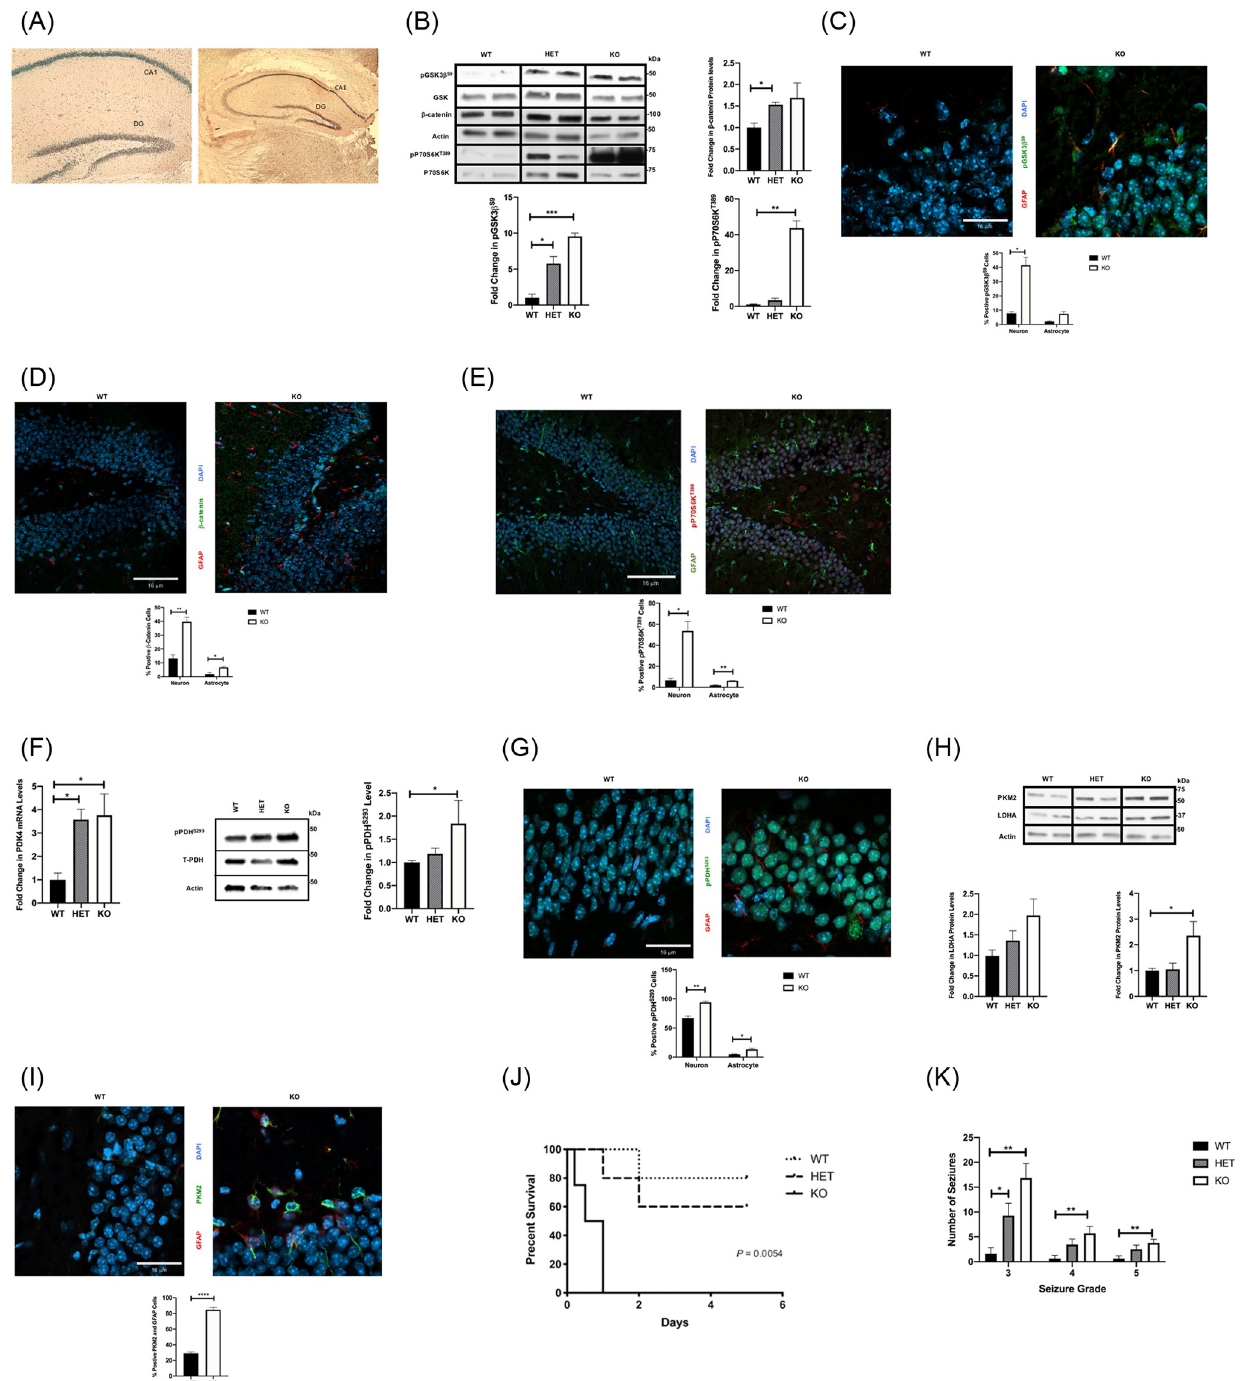
Fig 7. The role of HBP1 and Wnt signaling in acquired seizure susceptibility. (A) HBP1 gene is expressed in the CA1 and DG regions. The expression pattern of the HBP1 gene was determined in the HBP1 -/- mouse through the inserted β -galactosidase gene. Note that the HBP1 -/- mouse was generated by insertion of the β -galactosidase gene into intron 1 of the HBP1 genomic loci [72]. Thus, β -galactosidase activity is driven by the HBP1 promoter and is a reporter of the HBP1 promoter activity. Representative slides of HBP1 -/- adult mouse hippocampus with β -galactosidase gene inserted into intron 1 of HBP1 gene. (B) Activation of Wnt and mTOR signaling in HBP1 -/- and HBP1 +/- mice. Representative western blot with quantified data of baseline levels of Wnt and mTOR signaling markers in FVBN mouse strain were increased in HBP1 -/- knockout (KO) and HBP1 +/- heterozygous (HET) when compared to control (WT). (C-E) Localization of activated Wnt and mTOR signaling in HBP -/- mice by confocal microscopy. Representative confocal sections with quantified analysis of positive pGSK3 β S9 (green; x63 in C), β -catenin (green; x20 in D), and pP70S6K T389 (red; x20 in E) neuronal cells are increased in the